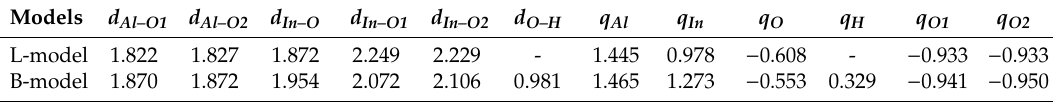
Table 1. Calculated bond length ( d , Å) and Mulliken charge population ( q , e) of L-model and